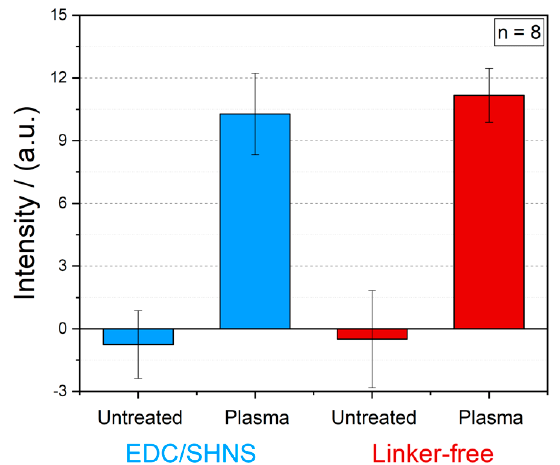
Figure 6. Comparison of two different immobilization techniques on the antibody immobilization: (i) EDC / SHNS based and (ii) linker-free immobilization of gold nanoparticle labelled antibodies on the untreated and plasma treated PMMA foils (100% O 2 , 5 min, 1000 W, 80 °C).